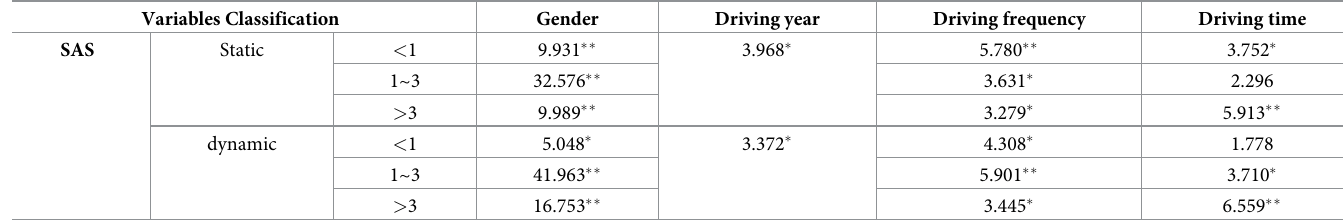
Table 4. One-way ANOVA between drivers’ SAS and their characteristics. Variables Classification